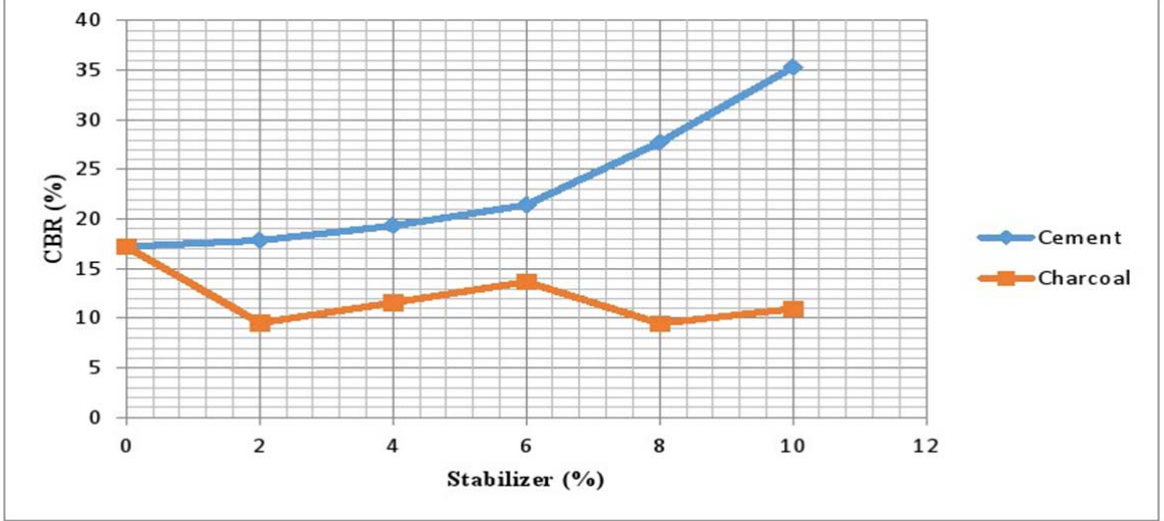
Figure 4. Variation of CBR with percentage of